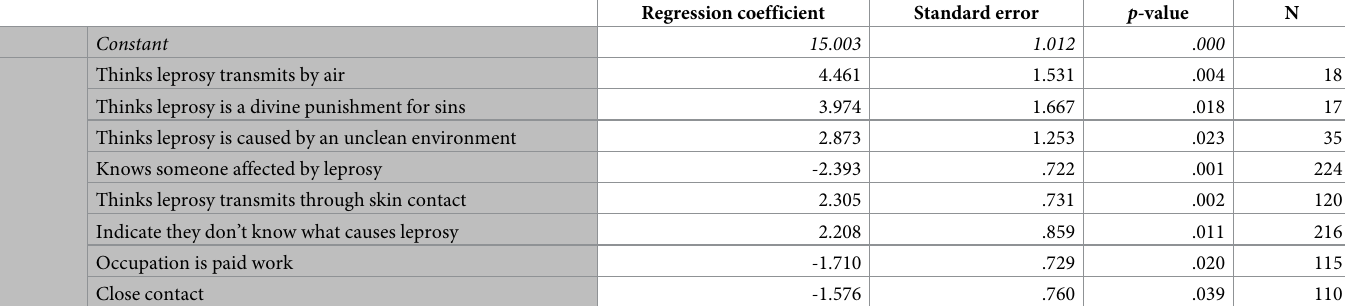
Table 5. Correlations between level of stigma and the other variables in the dataset. This model explained 15% of the variability of stigma towards persons affected by leprosy (R-squared =